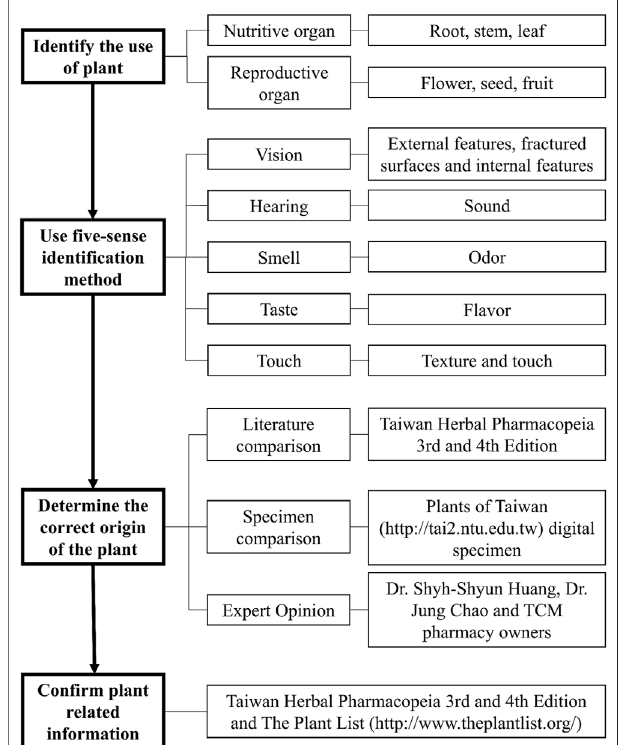
FIGURE 3 | Flowchart for medicinal materials identi fi